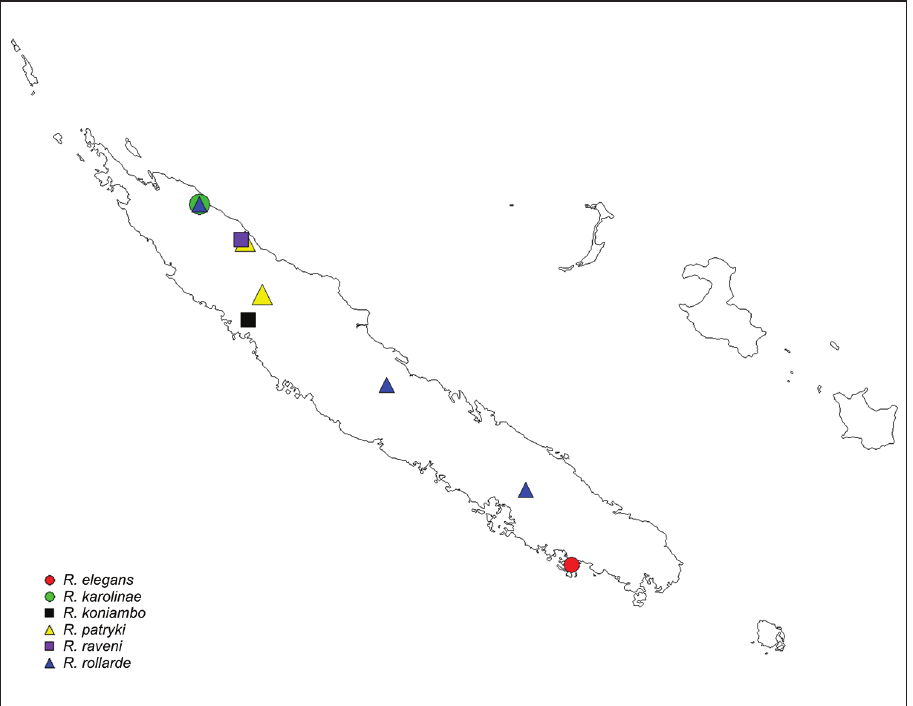
Figure 44. Distribution records of Rogmocrypta : R. elegans (red circle), R. karolinae (green circle), R. koniambo (black square), R. patryki (yellow triangle), R. raveni (purple square), R. rollardae (blue